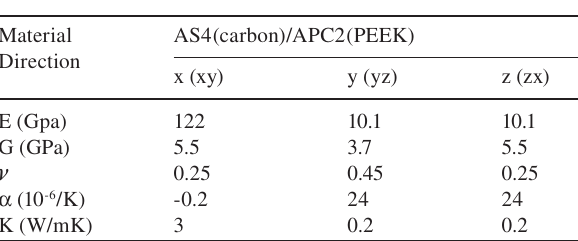
Table 1 Material properties of APC2.